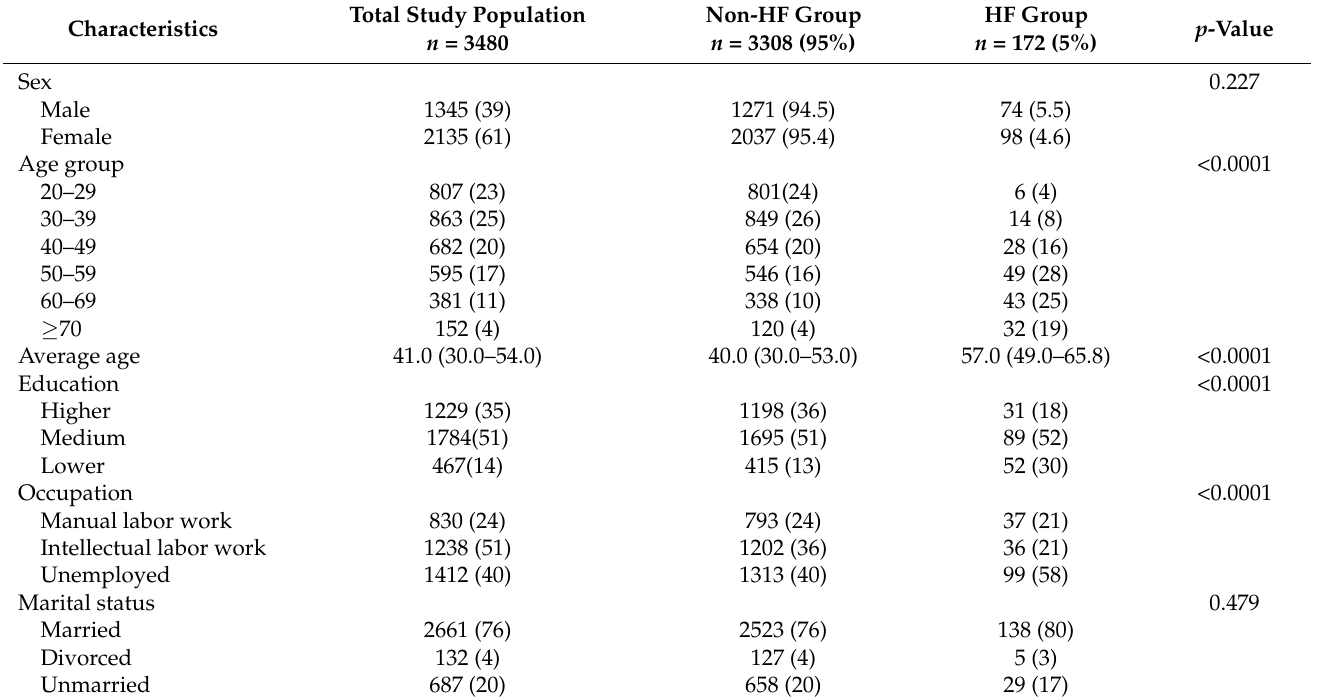
Table 4. Comparison of demographic and social characteristics between HF and non-HF